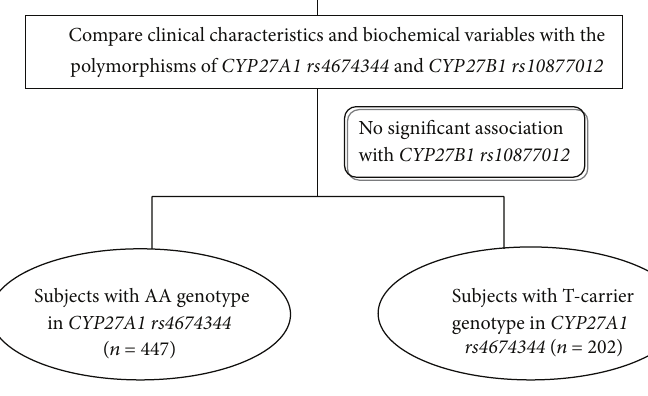
Figure 1: Flow chart of this cohort